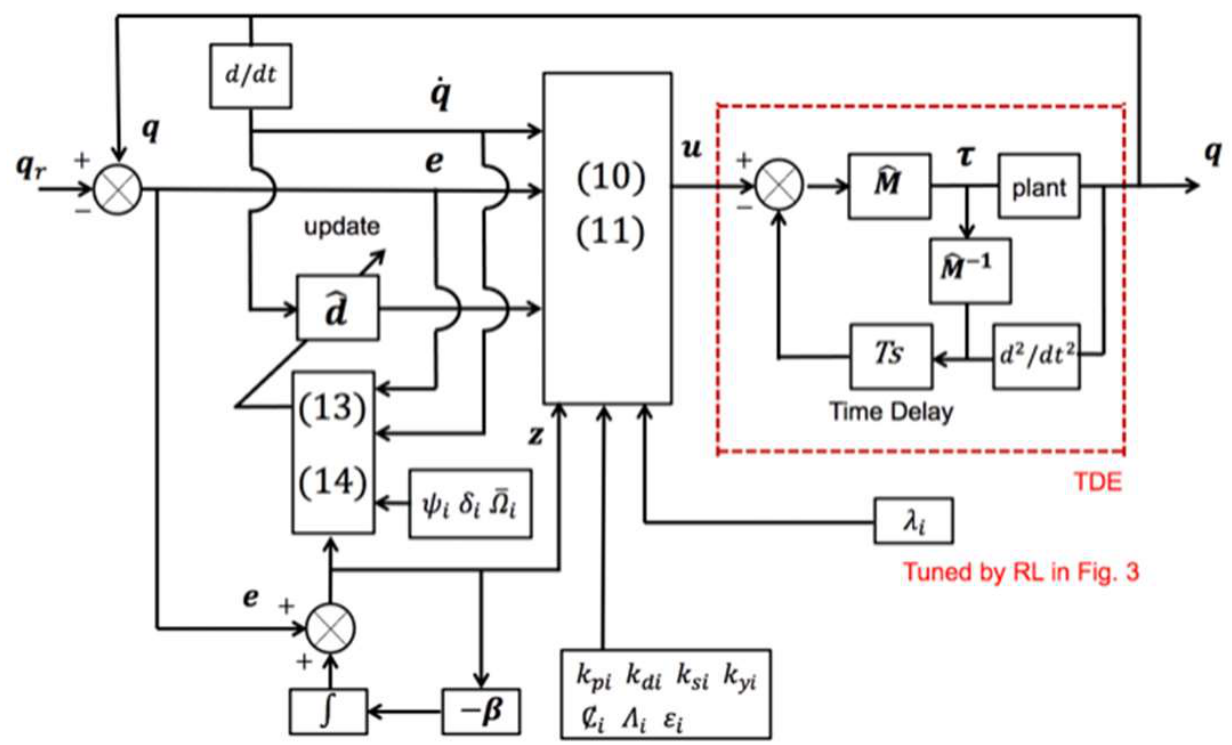
Figure 3. Flow chart of fuzzy Q learning to determine 𝜆